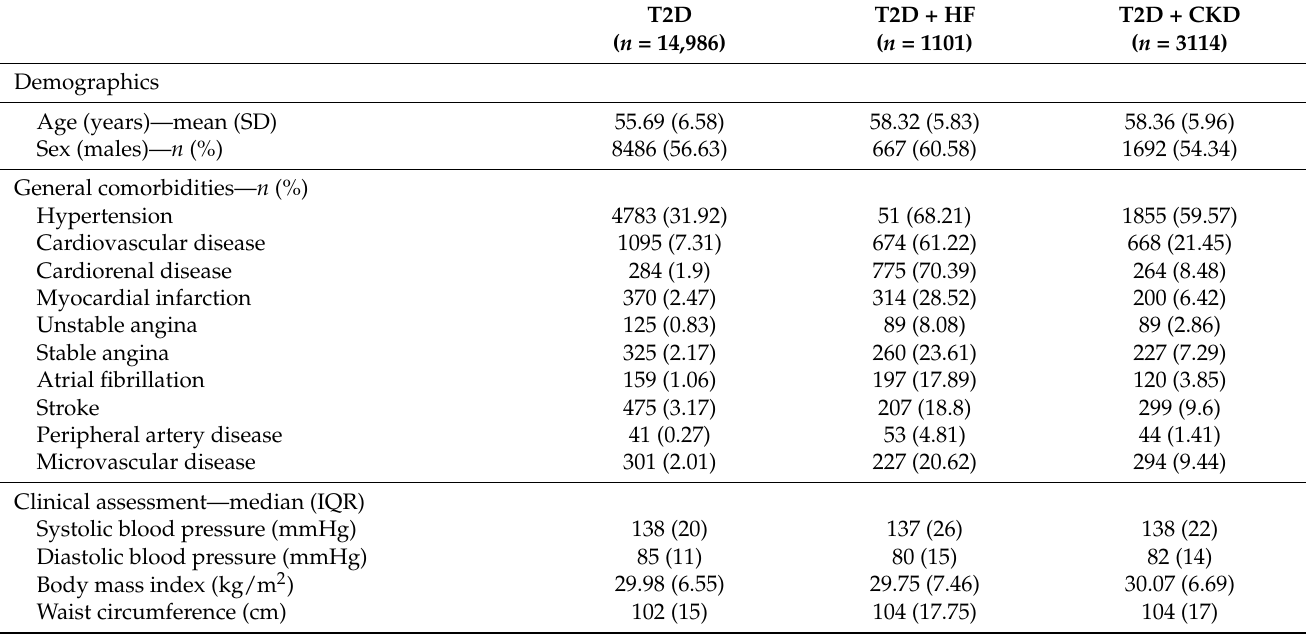
Table 1. Baseline characteristics of the cohorts at the onset of diabetes mellitus type 2, heart failure, and chronic kidney